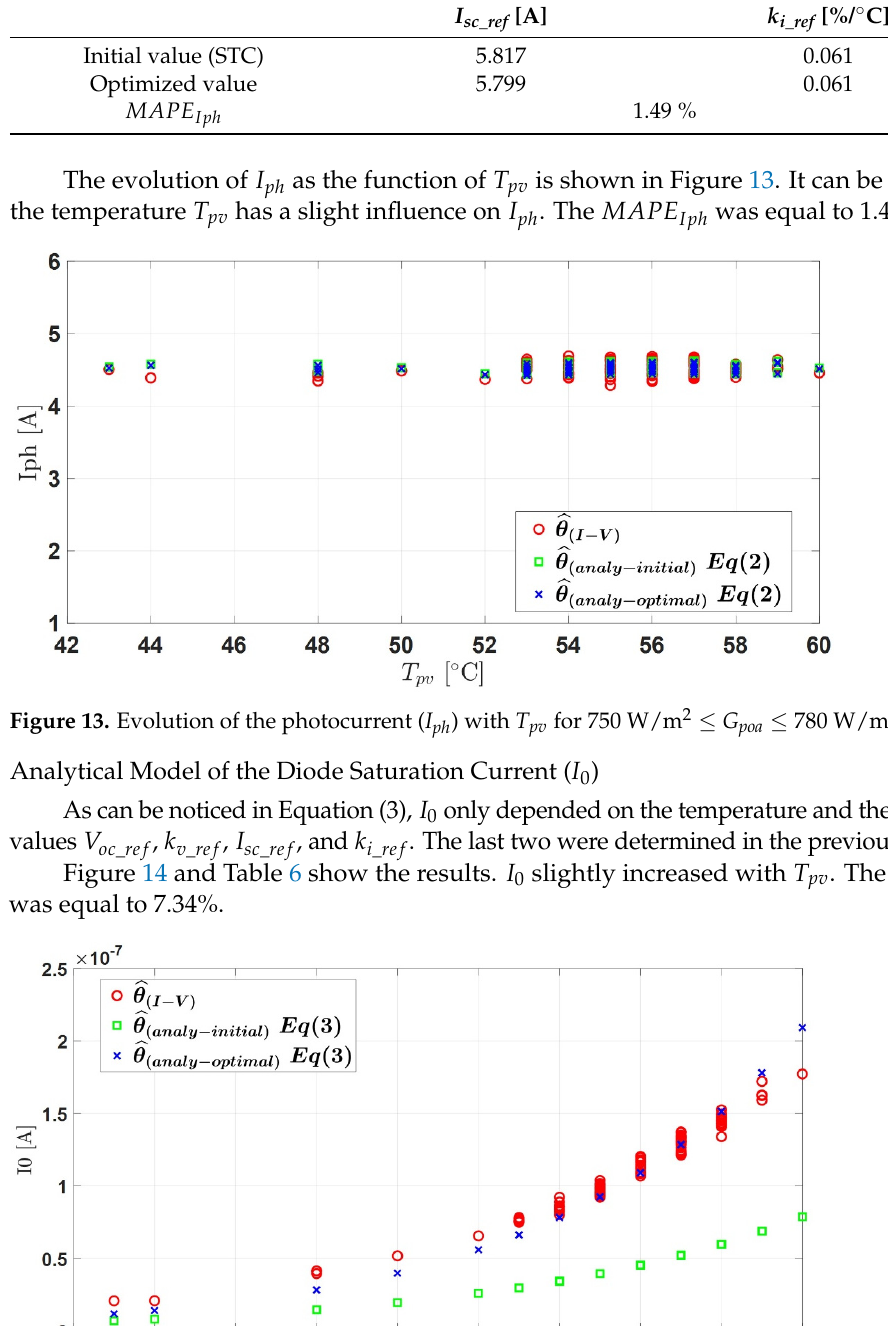
Table 5. Extracted reference values for constant G poa for the photocurrent model.